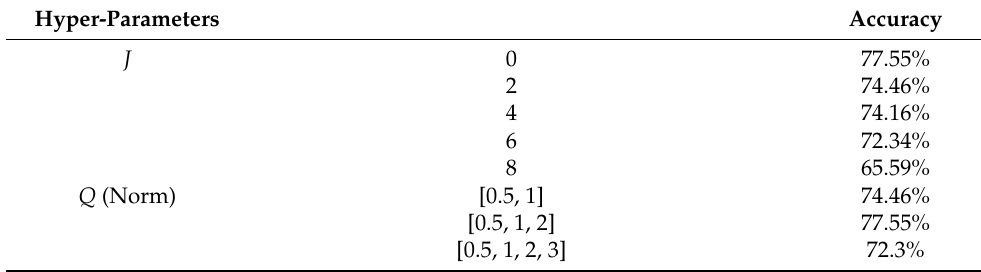
Table 2. Recognition accuracy during the hyper-parameter tuning